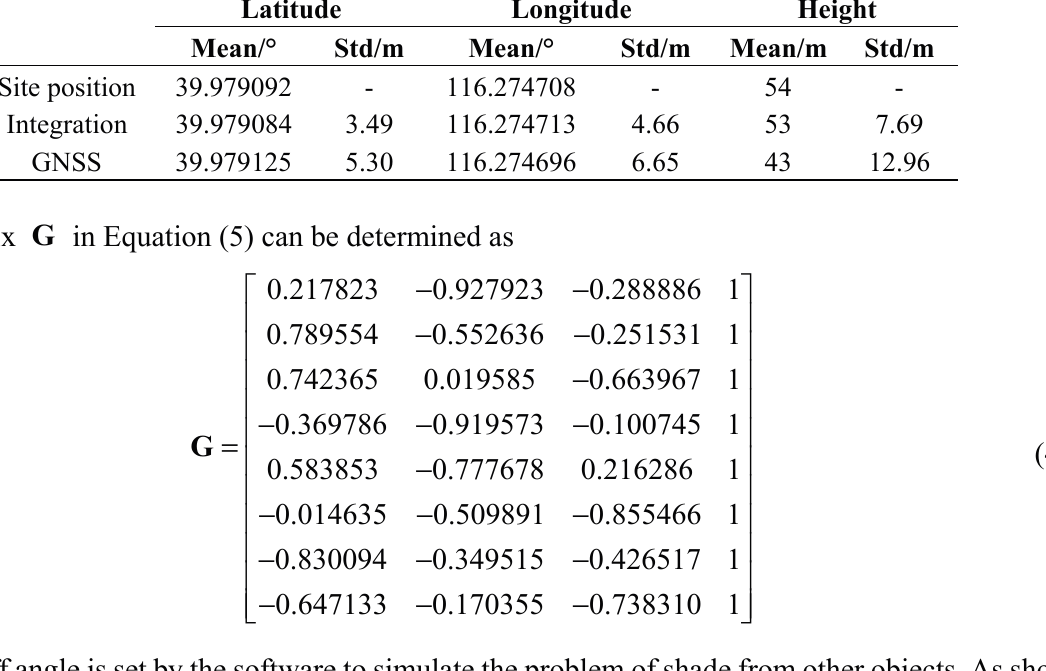
Table 4. Comparisons of the integration and GNSS with crystal oscillator.